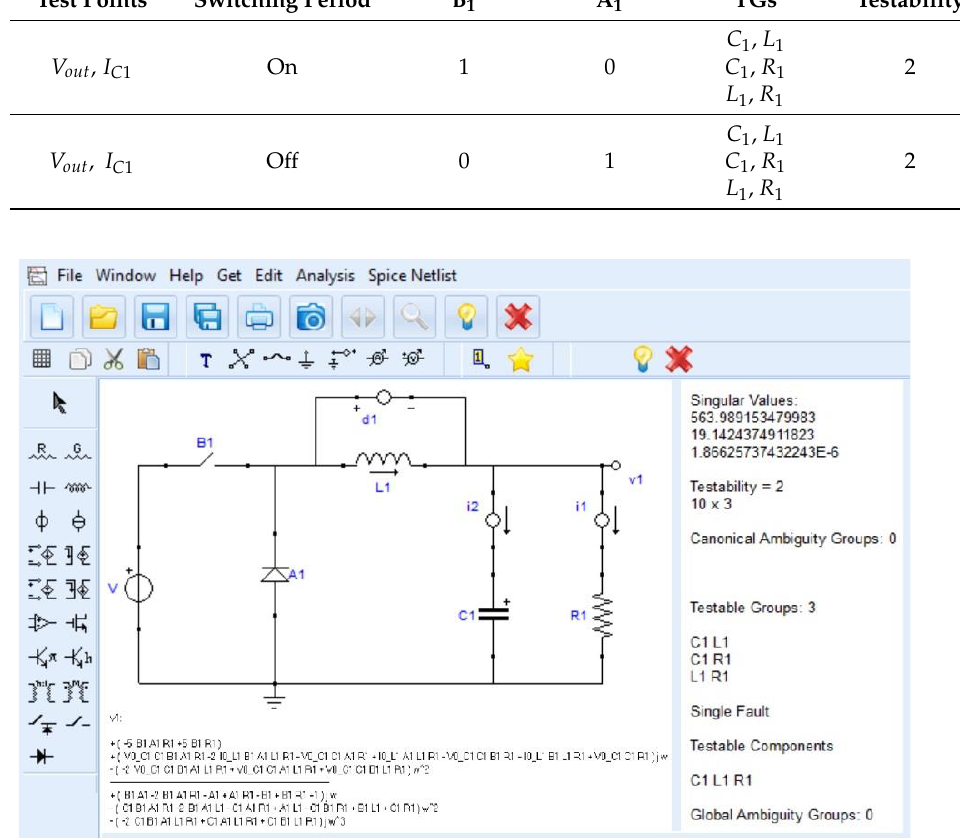
Figure 6. TAPSLIN user interface.